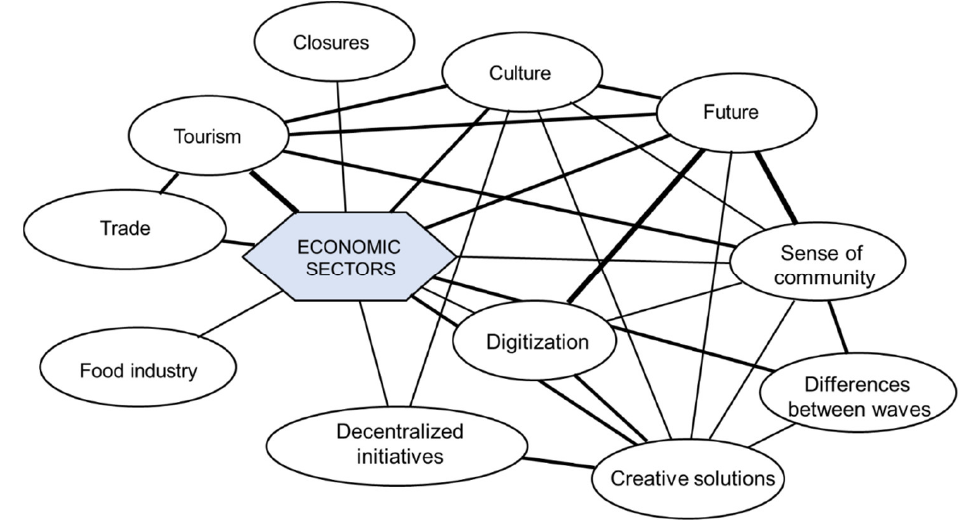
Figure 3. Economic sectors in Merano (N = 14, expansion factor = 3).